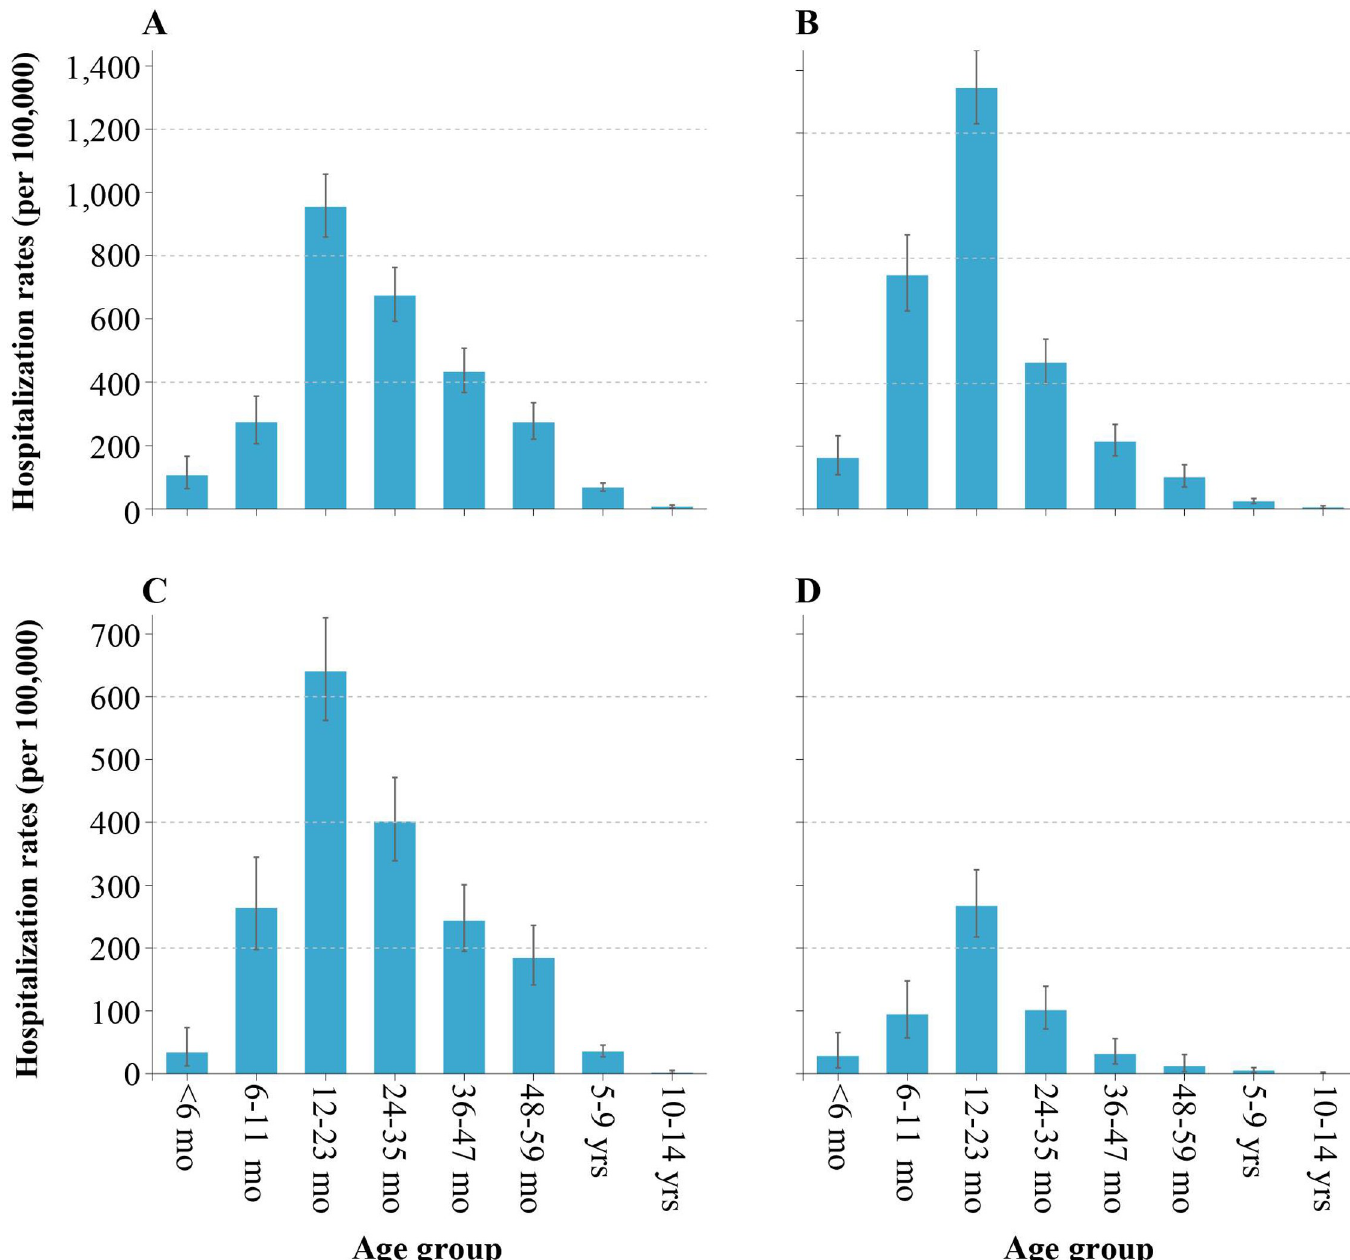
Fig 4. Age-specific and serotype-specific hospitalization rates associated with HFMD in Anhua County, China, October 2013—September 2016. (A) Average age- specific hospitalization rates of CV-A16-associated HFMD. (B) Average age-specific hospitalization rates of CV-A6-associated HFMD. (C) Average age-specific hospitalization rates of EV-A71-associated HFMD. (D) Average age-specific hospitalization rates of CV-A10-associated